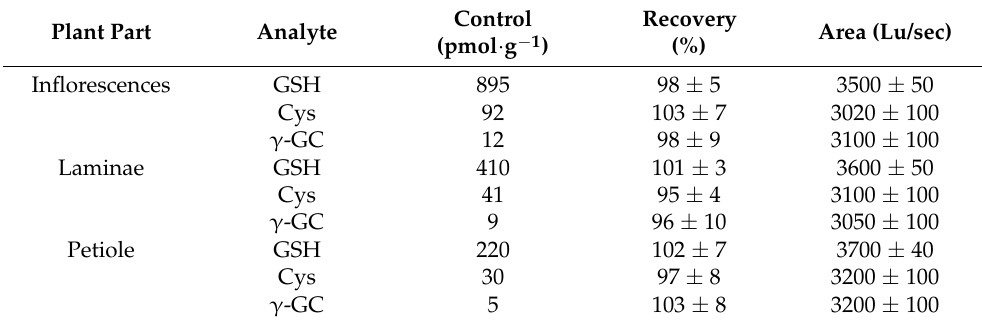
Table 2. Recovery percentage of GSH, Cys and γ -GC in plant part of B. rapa . The amount of analyte that was added in the range of concentrations nmol of added analyte varied dependent upon endogenous concentration in each vegetable. Ranges were as follows: GSH, 78–253; GSSG, 41–142; CYS, 41–104; CSSC,